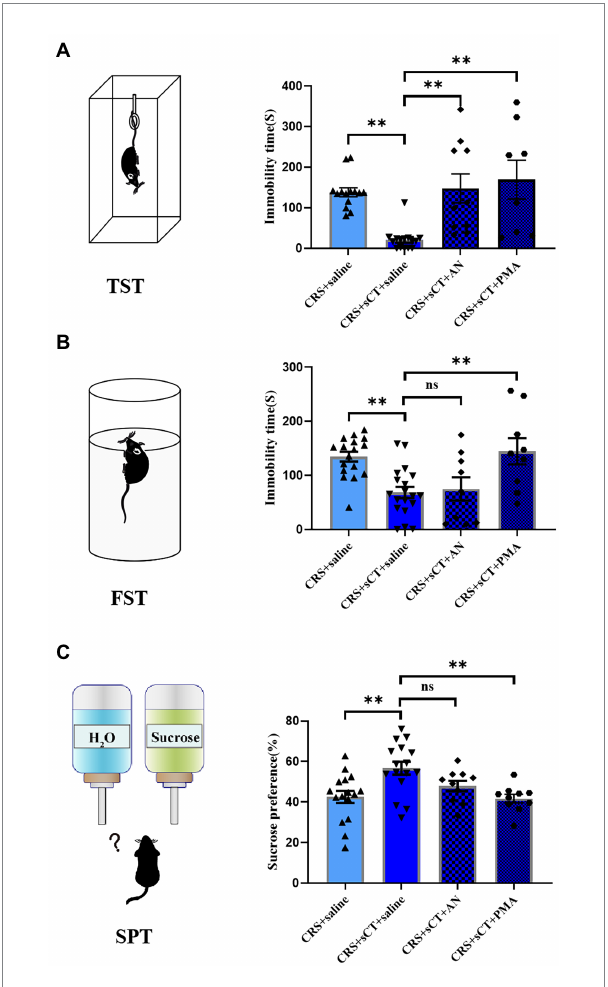
FIGURE 6 PMA treatment could block the antidepressant effect of sCT in CRS- treated mice. (A) In TST, the immobility time of CRS-treated mice with sCT treatment was increased after PMA or AN treatment (Depression + saline: n = 14; Depression + sCT + saline: n = 15; Depression + sCT + AN: n = 10; Depression + sCT + PMA: n = 8). (B) In FST, the immobility time of CRS-treated mice with sCT treatment was increased after PMA treatment (Depression + saline: n = 17; Depression + sCT + saline: n = 19; Depression + sCT + AN: n = 9; Depression + sCT + PMA: n = 9). (C) In SPT, the surose preference of CRS-treated mice with sCT treatment was decreased significantly after PMA treatment (Depression + saline: n = 16; Depression + sCT + saline: n = 16; Depression + sCT + AN: n = 10; Depression + sCT + PMA: n = 10). The data were analyzed by one-way ANOVA with Tukey’s multiple comparison tests. ns, no significance, * p < 0.05, ** p <